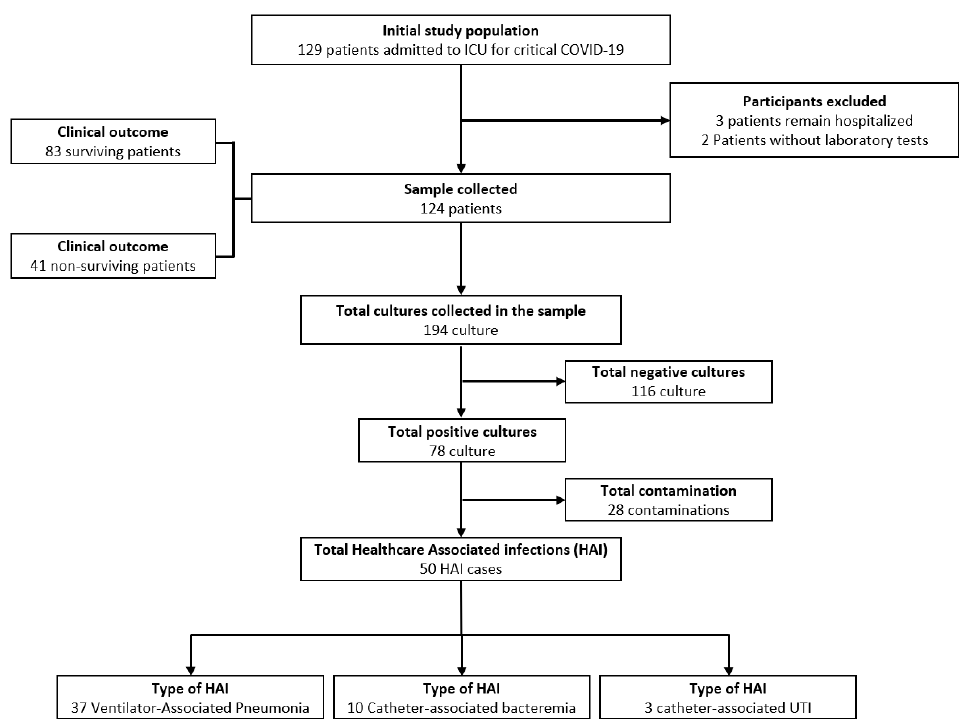
Figure 1. Sample selection flow chart.